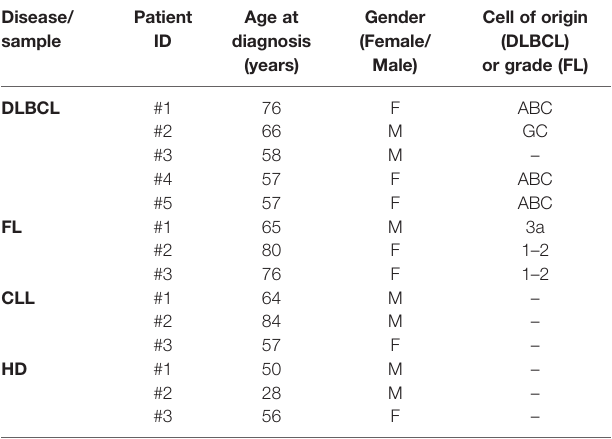
TABLE 1 | Patients ’